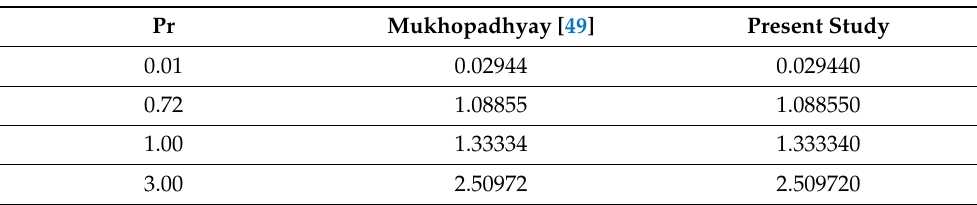
Table 2. Local Nusselt number validation in restricted situations (for example, K → ∞ and φ 1 = φ 2 = 0